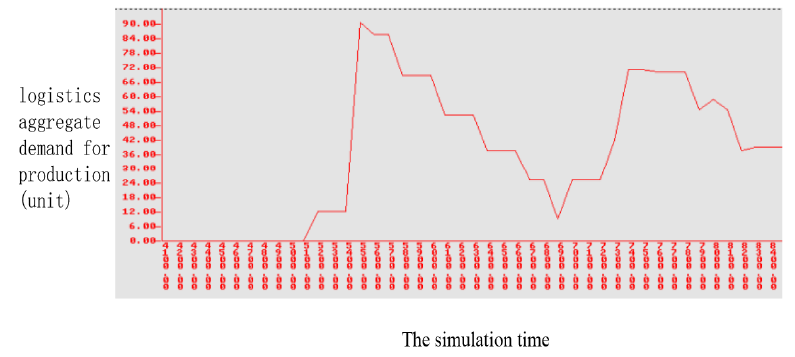
Figure 4. The total logistics demand